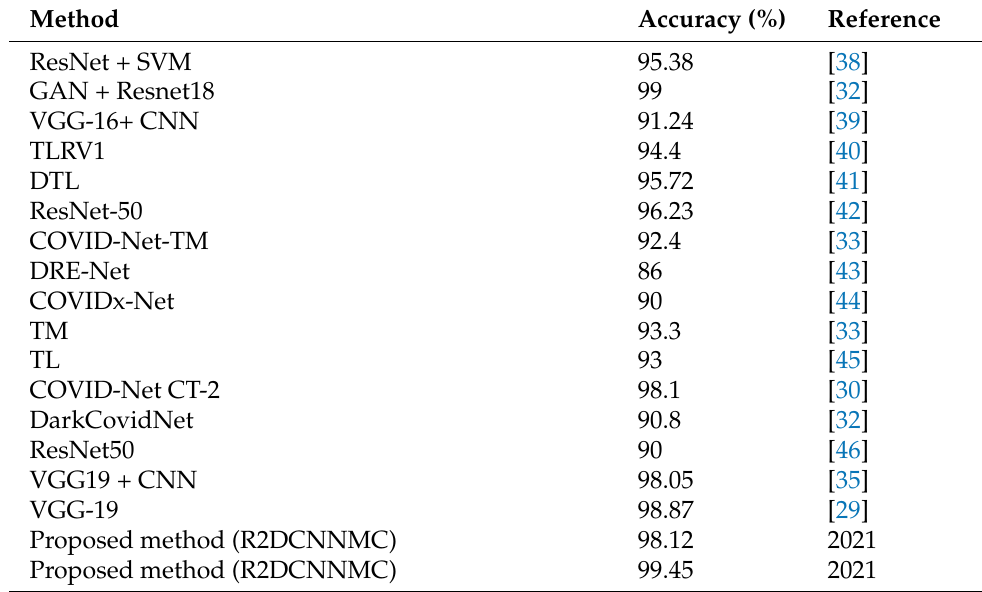
Table 6. R2DCNNMC model accuracy comparison with baseline